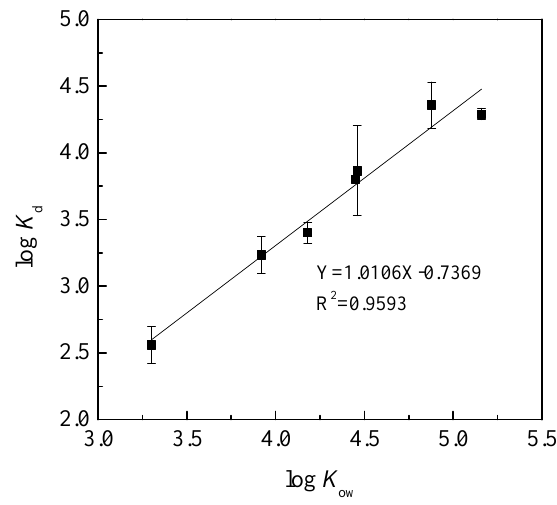
Figure 6. Relationship between the partitioning coefficient (log K d ) and the octanol–water partition coefficient (log K ow ) of different PAHs.